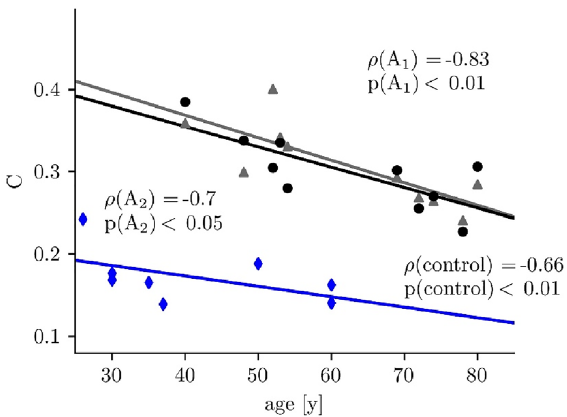
Figure 3. Scatterplot of average clustering coefficients C (all conditions: B1, S, B2) and age from patients at both assessments ( A1 : grey triangle; A2 : black dot) and healthy controls (blue). Solid lines represent linear regressions (Spearman’s correlation coefficient